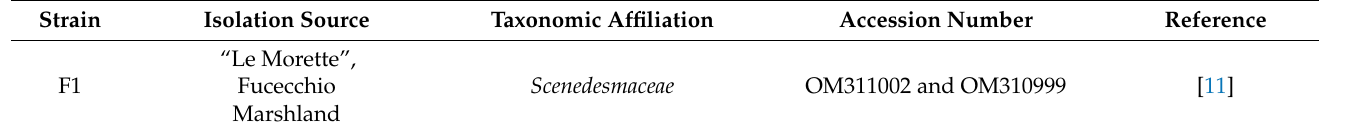
Table 1. List of microalgal